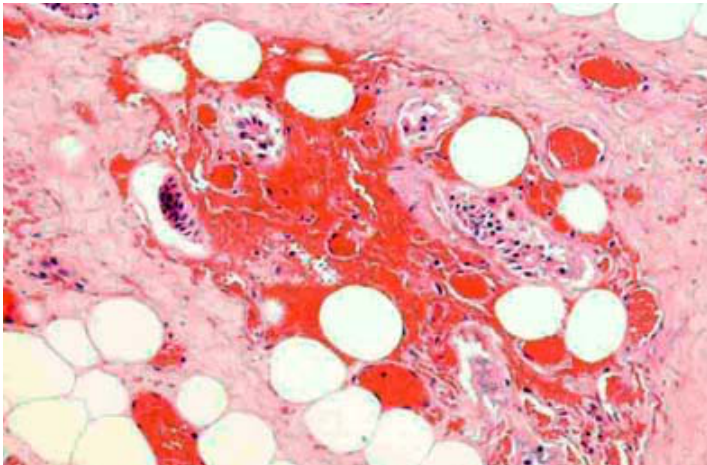
Figure 5. Histopathological findings of the fang mark site immediately after injury. Image shows red cell extravasation, vessel fibrinoid necrosis and subcutaneous hemorrhagic necrosis with neutrophil infiltration.